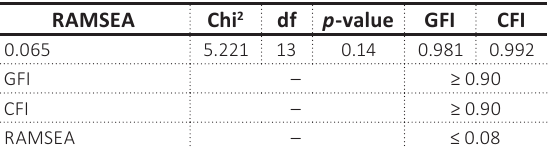
Table 7. Path analysis